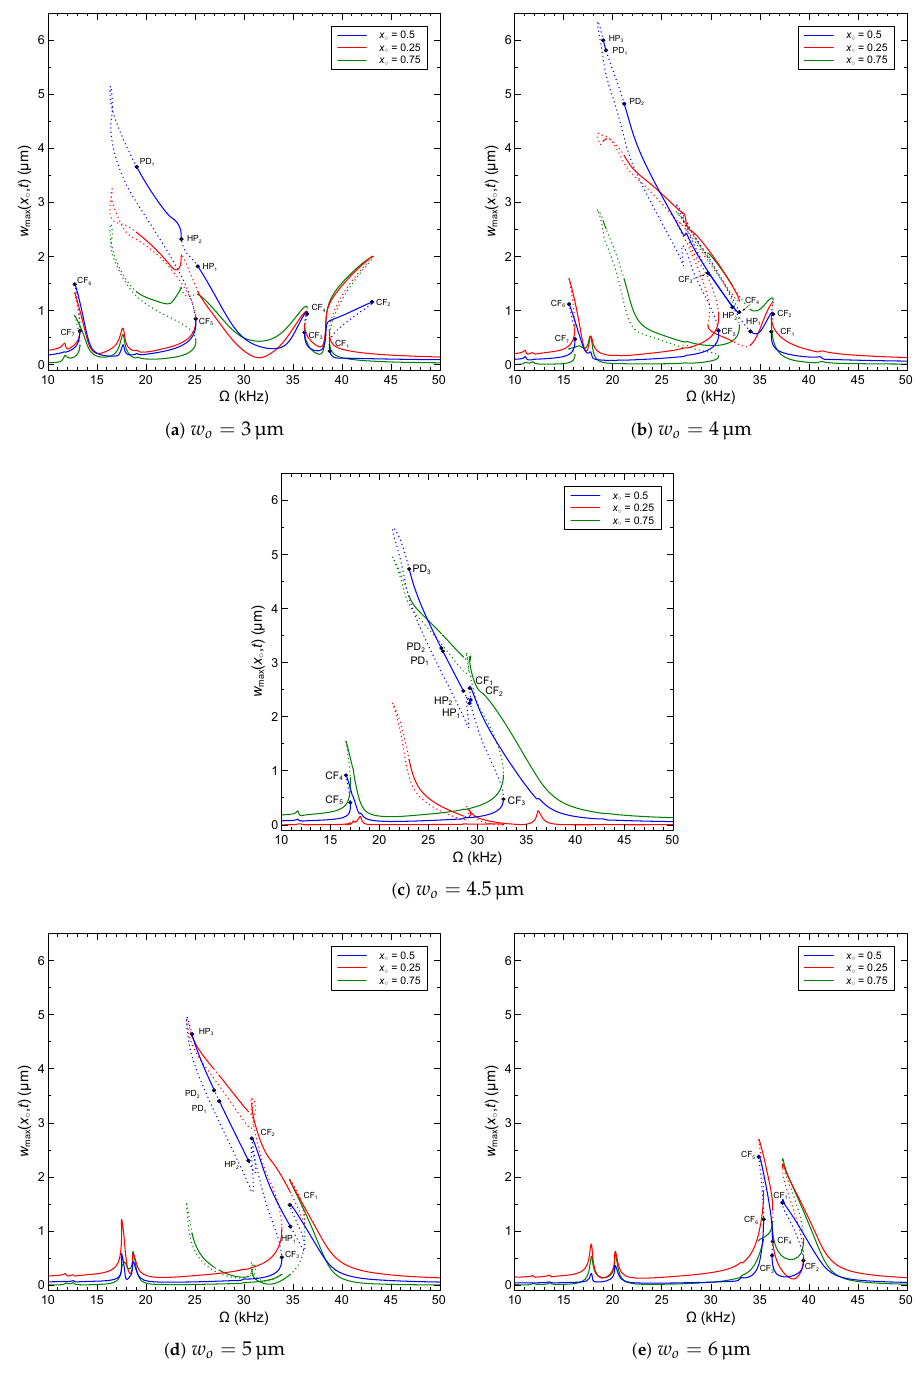
Figure 12. The frequency-response curves of an arch microbeam with an initial rise of ( a ) w o = 3µm, ( b ) w o = 4µm, ( c ) w o = 4.5µm, ( d ) w o = 5µm and ( e ) w o = 6µm excited by a half-electrode with the voltage waveform V DC = V AC = 12.2V. Stable orbits are marked by solid lines. Unstable orbits are marked by dashed